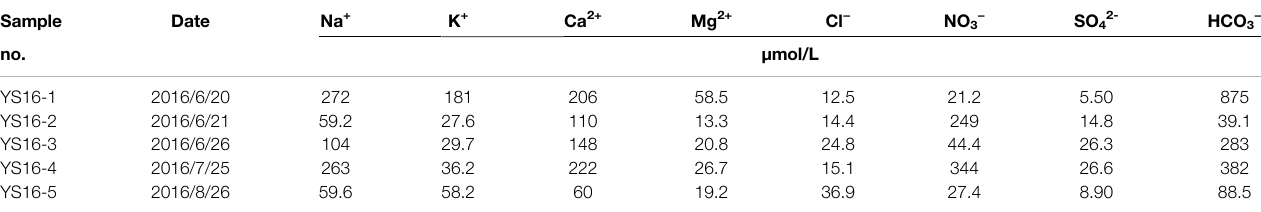
TABLE 2 | Concentrations of major ions in rain waters collected from the Datong River catchment in 2016.